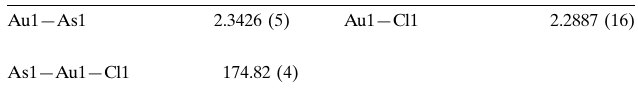
Selected geometric parameters (A˚ , (cid:2) ).